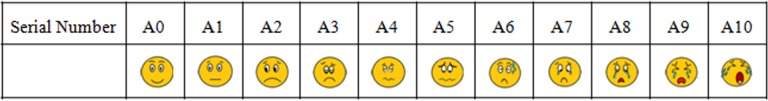
A total of 11 facial expressions were designed to reflect differing levels of stressfulness.